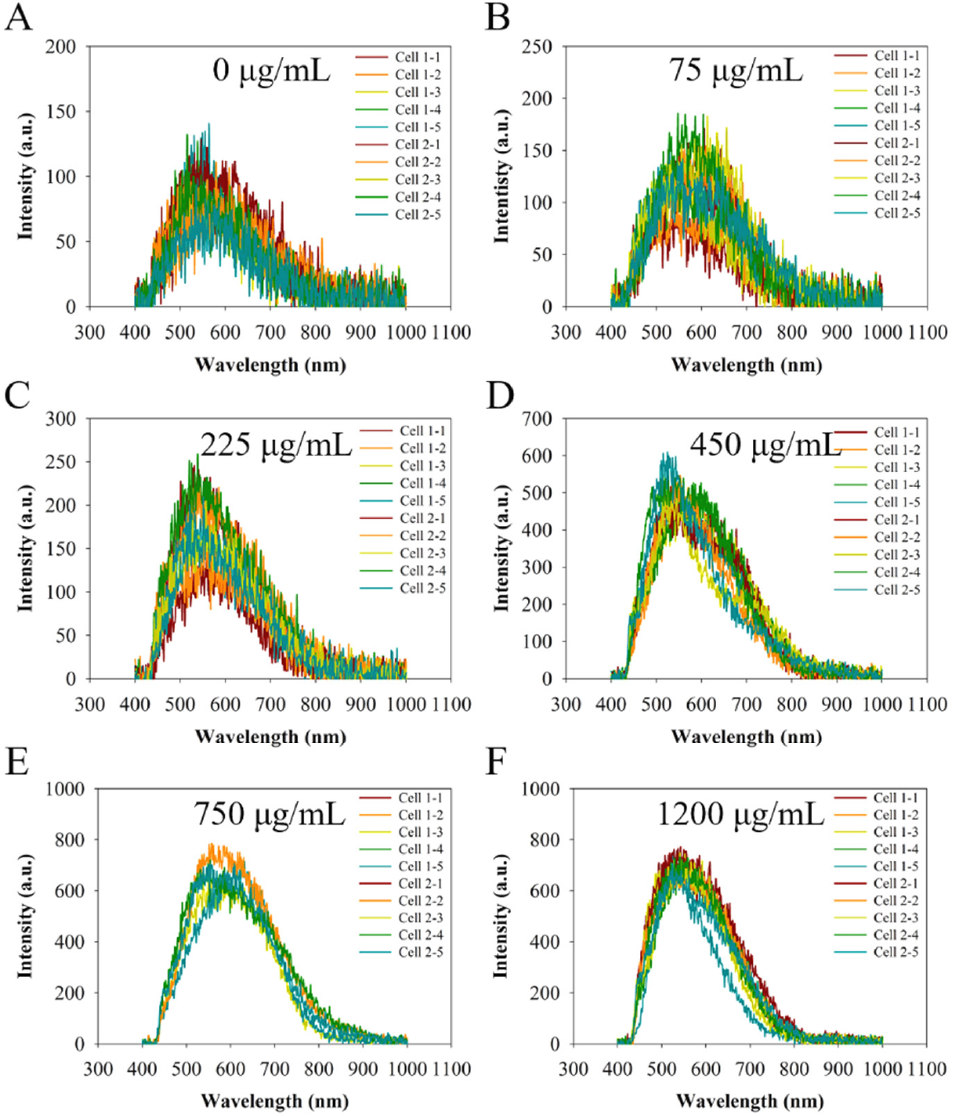
Figure 6. Light intensity measurements of cells (34 measurements) incubated without CNDs ( A ) or with CNDs for 24 h using different concentrations ranging from 75 µg/mL to 1200 µg/mL ( B – F ).